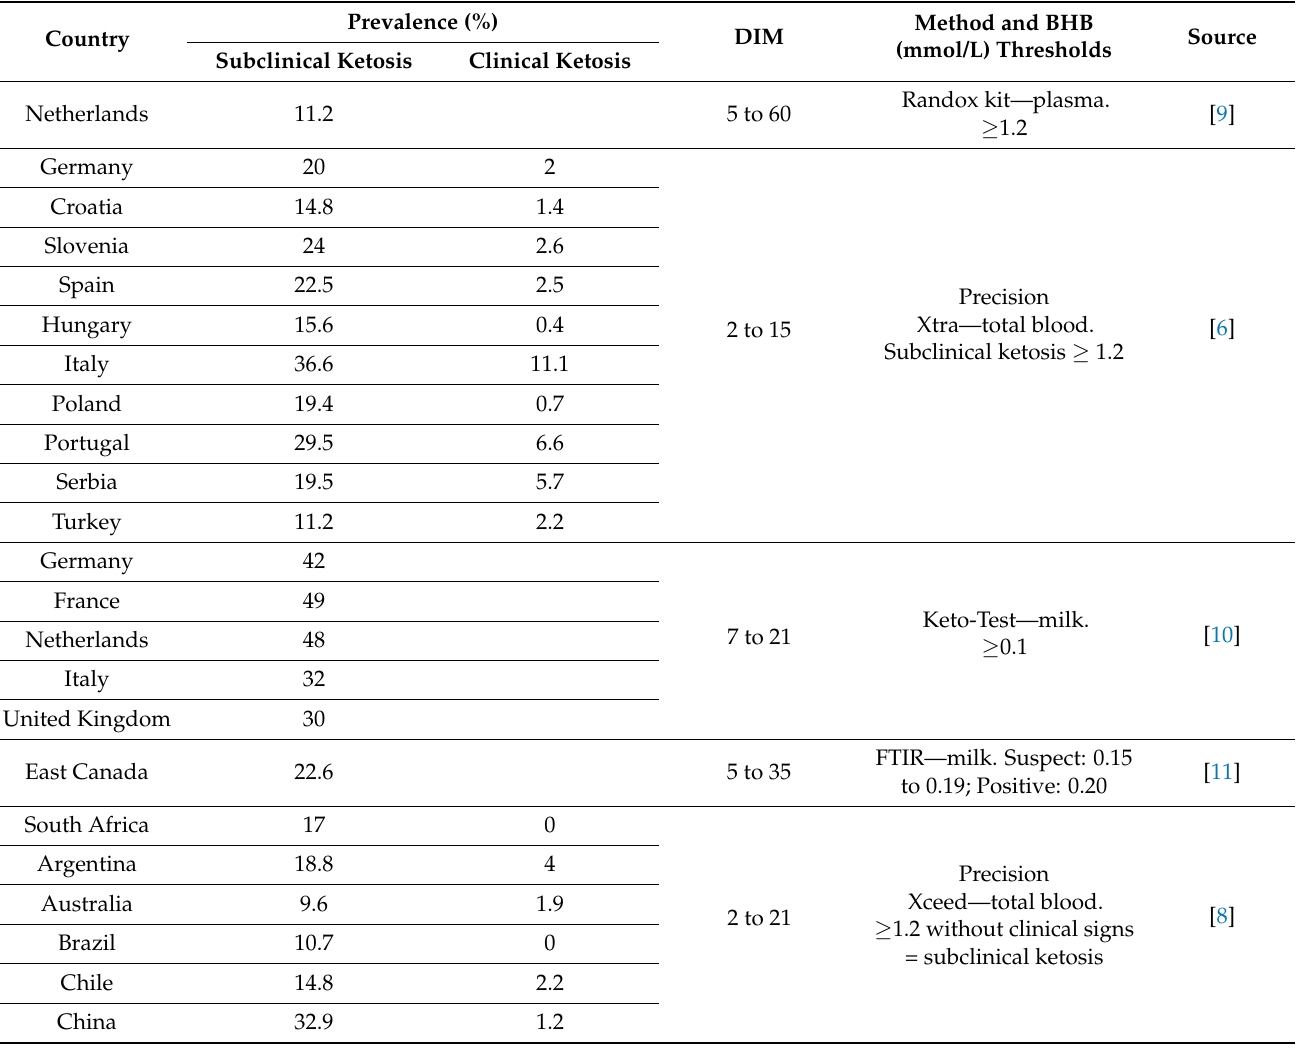
Table 1. Ketosis prevalent in several countries of the world.